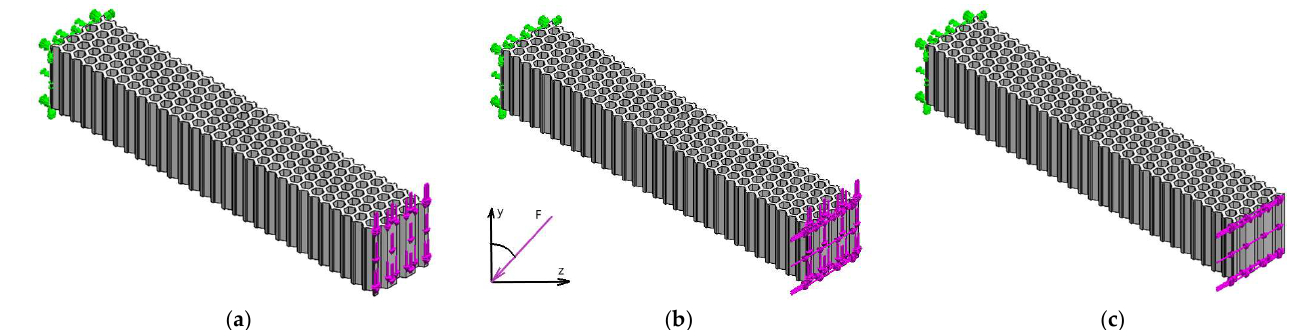
Figure 13. The FEM analysis setup for asymmetric bending of the hexagonal structure: ( a ) α = 0°, ( b ) α = 45°, ( c ) α = 90°.